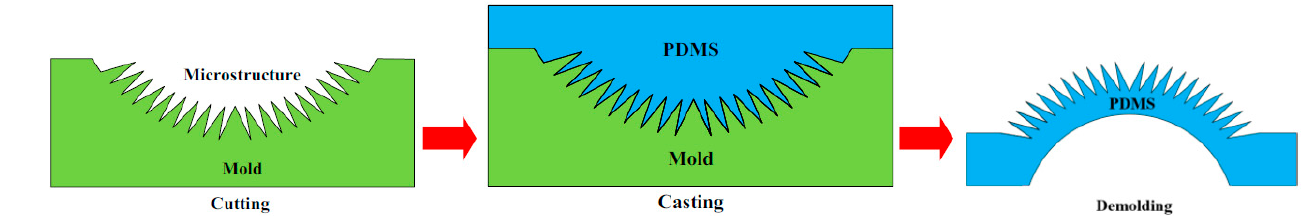
Figure 11. Sketch of the demolding process. Figure 12. PDMS material with microstructure.